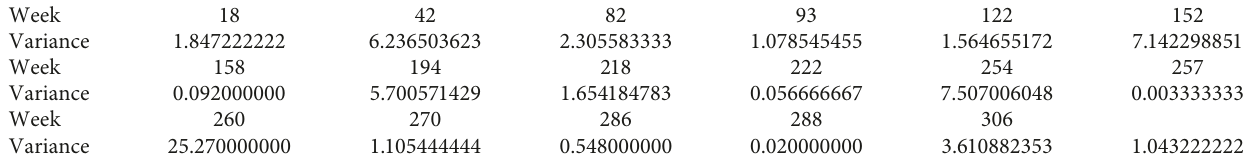
Table 8: Location of change points determined with the PELT method.